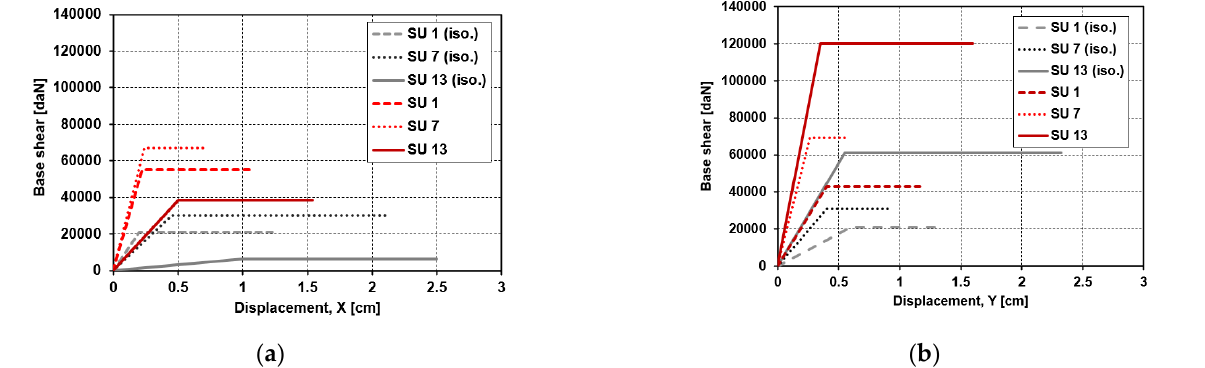
Figure 10. Capacity curves of the examined SUs in X- ( a ) and Y- ( b ) directions.